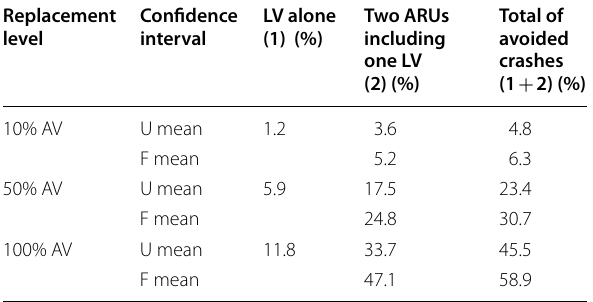
Table 3 Average percentage* of avoided crashes for injury crashes